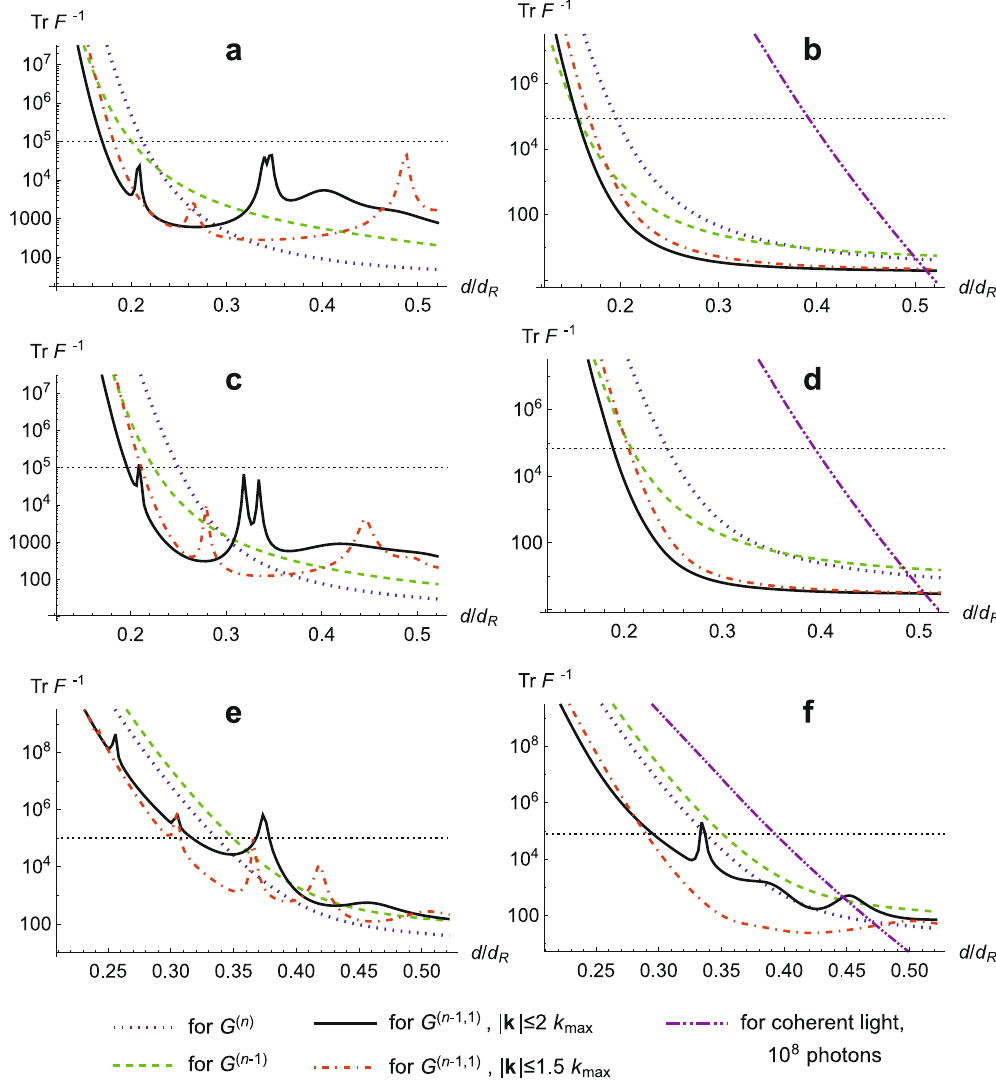
Fig. 4 Dependence of the trace of inverse FIM on the normalized slit size d/dR. The results are shown for detection of n th-order correlations (blue dotted lines), ( n − 1)th-order correlations (green dashed lines), and ( n − 1)th-order correlations, conditioned by detection of the n th photon in the region Ω ¼ f k : k max (cid:6) j k j (cid:6) 2 k max g (black solid lines) and Ω ¼ f k : k max (cid:6) j k j (cid:6) 1 : 5 k max g (red dot-dashed lines) for n = 4 ( a , b ), 3 ( c , d ), and 2 ( e , f ). The objects, shown in Fig. 3a (for plots a , c , and e ) and Fig. 3c (for plots b , d , and f ), were decomposed in terms of 10 basis functions, representing slit-like pixels with equal widths d . The object size, the basis functions widths, and the step of the signal sampling points were scaled in the same way with d . Horizontal dotted lines indicate the threshold Tr F (cid:2) 1 (cid:6) N max ¼ 10 5 , used for quanti fi cation of resolution. For comparison, panels b , d , f also show (by double-dot-dashed purple lines) the trace of inverse FIM for traditional coherent-light imaging for detection of 10 8 photons (instead of a single coincidence event for all other